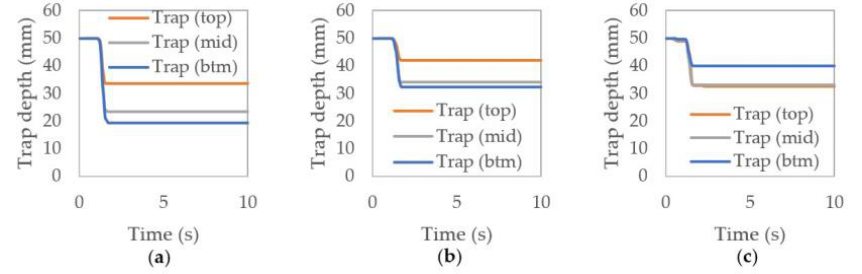
Figure 12. Simulated resultant trap retention depths for the 20 story building with 150 mm diameter stack for ( a ) modified one‐pipe; ( b ) fully‐vented; and ( c ) single stack with